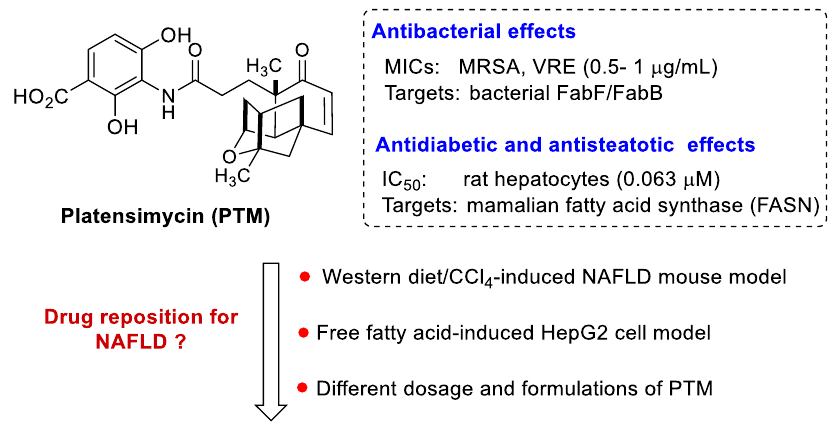
Figure 1. Targeting de novo lipogenesis against NAFLD by